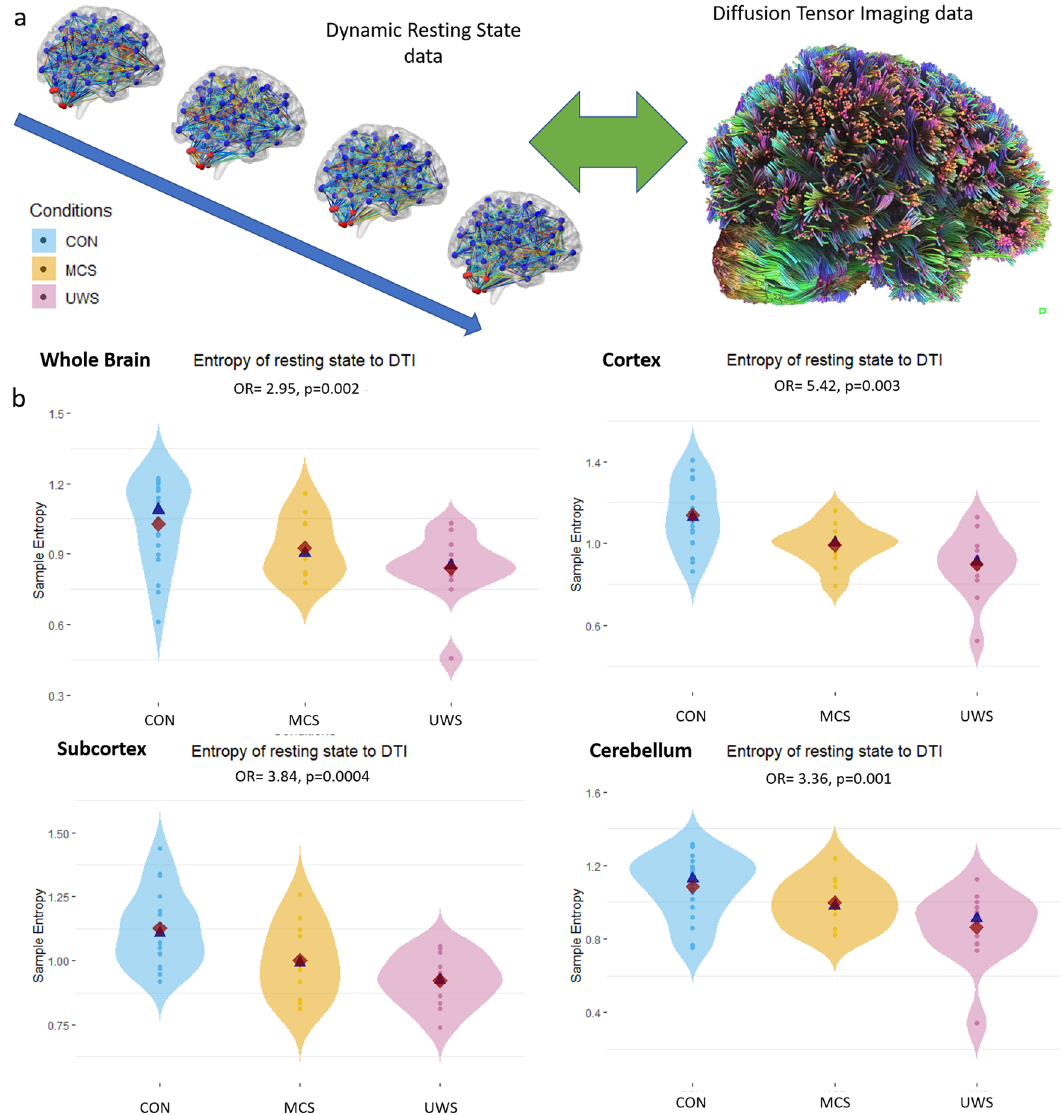
Fig. 4 Complexity of structure-function dynamic relationship. Illustration of method (a) for the sample entropy of the relationship between functional dynamic and tractography of diffusion tensor imaging data. We measured the similarity (using Pearson ’ s correlation) of each dynamic functional connectivity state to that of the underlying structural connectivity (measured via tractography). From this we obtained a string of similarity values on which complexity measures (sample entropy and effort to compress) were calculated. This value was then inserted as the predictor variable into an ordinal logistic regression. Conditions, ordered according to presumed level of awareness (control awake > minimally conscious state> unresponsive wakefulness syndrome), were the dependent variable (b). Shown are the results for the whole brain, the cortex, the subcortex and cerebellum. DTI = diffusion tensor imaging, Con = control awake n = 18, MCS = minimally conscious state n = 11, UWS = unresponsive wakefulness syndrome n = 12 (n = 11 for cerebellar results). OLR = ordinal logistic regression. Red diamonds represent the mean while blue triangles the